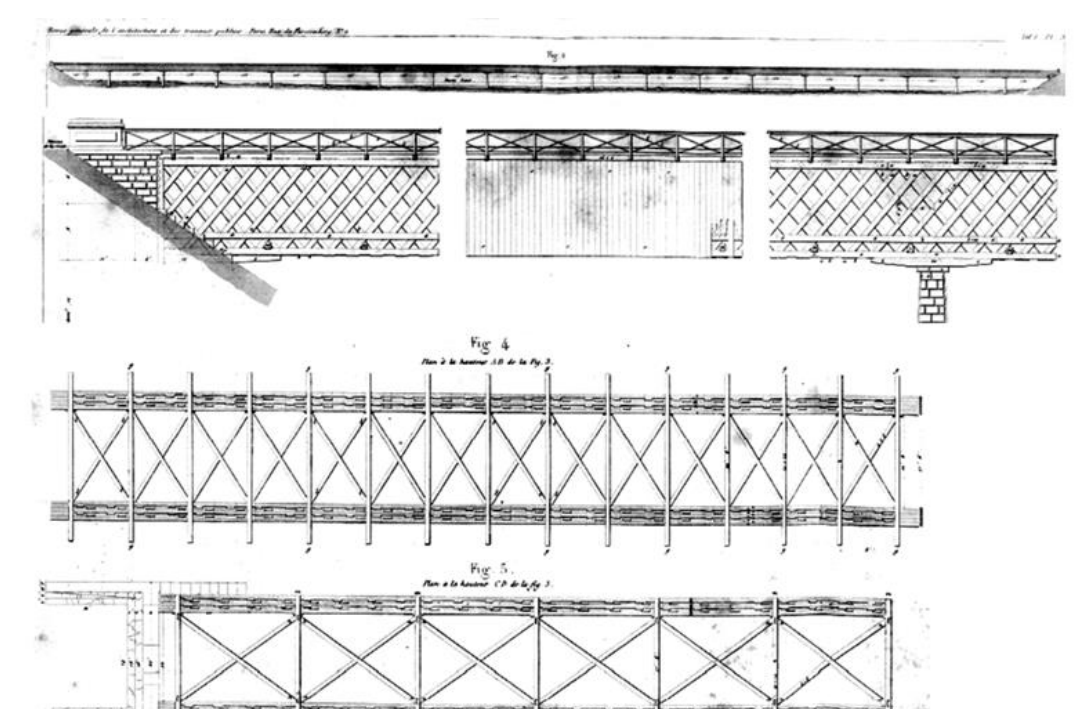
Figure 7. Bridge over the James River. Longitudinal elevation and section. Designed by M. Michel Chevalier located in Richmond, Virginia. 1840. Source: “ Revue Générale de l ’ architecture et des Travaux Publics ” , France, 1840. Vol.1, (Pl.3). Edited by César Daly. Reference [16].